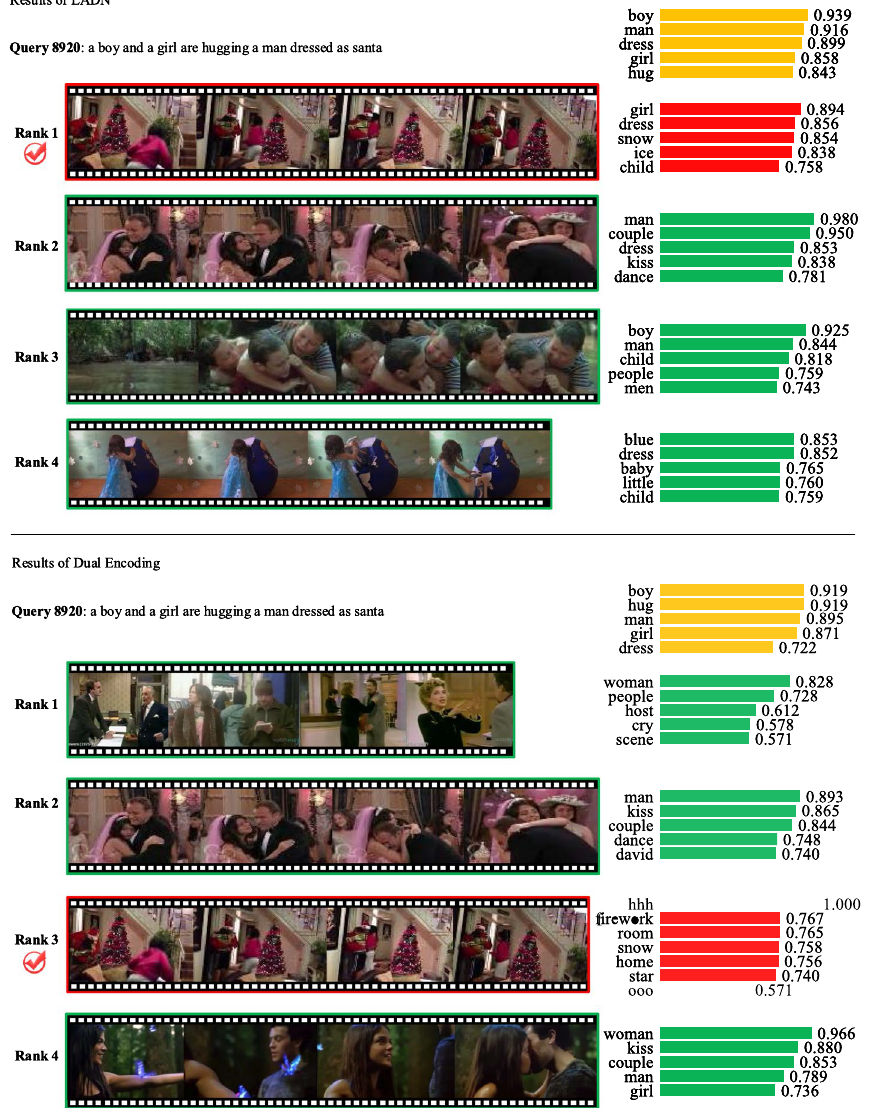
Fig. 3 The text-to-video retrieval results of our LADN method and Dual Encoding on the MSR-VTT B partition [18]. The top 4 ranked videos are shown for each query, where the ground truth is marked with a red box, and the others are marked with a green box. The last column is the predicted concepts corresponding to the second